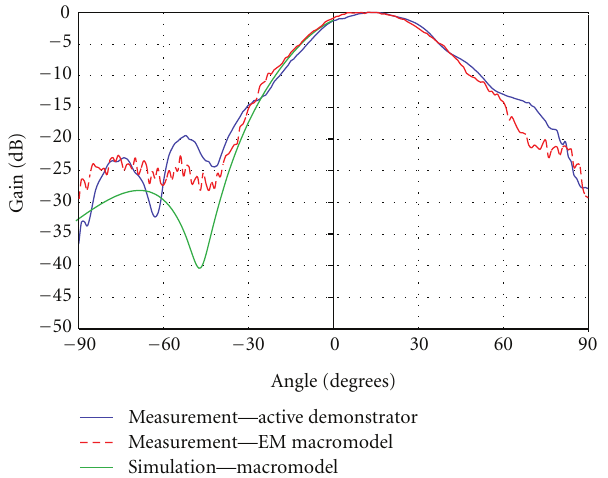
Figure 23: Radiation pattern comparison (+15 ◦ ). Active demonstrator measurement (solid line). Measurement without PA (big dashed line). EM macromodel simulation (small dashed line). F 0 = 8 . 2